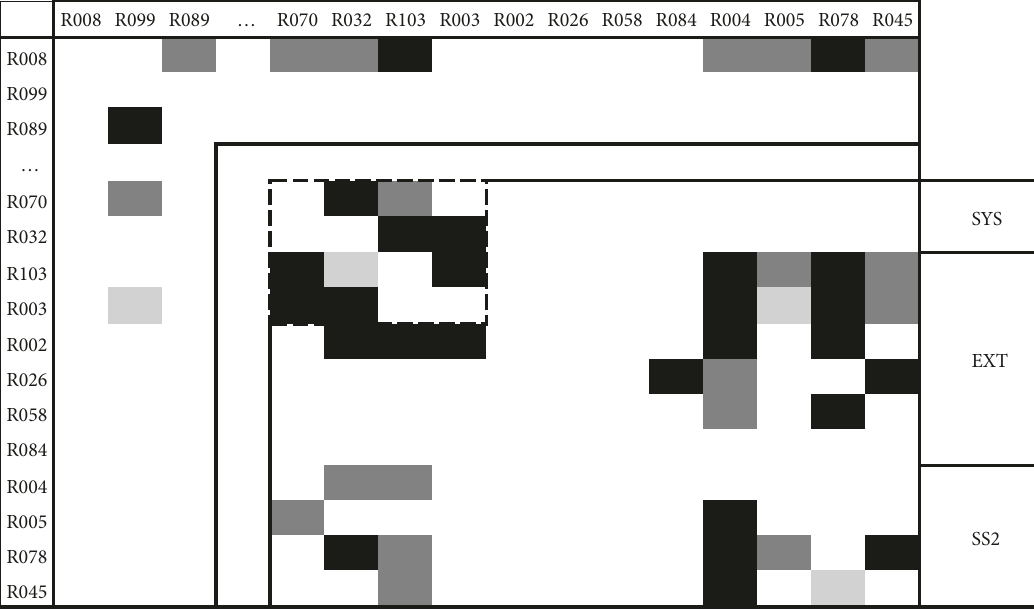
Figure 9: Cluster C 5 and its lower connections with the transverse